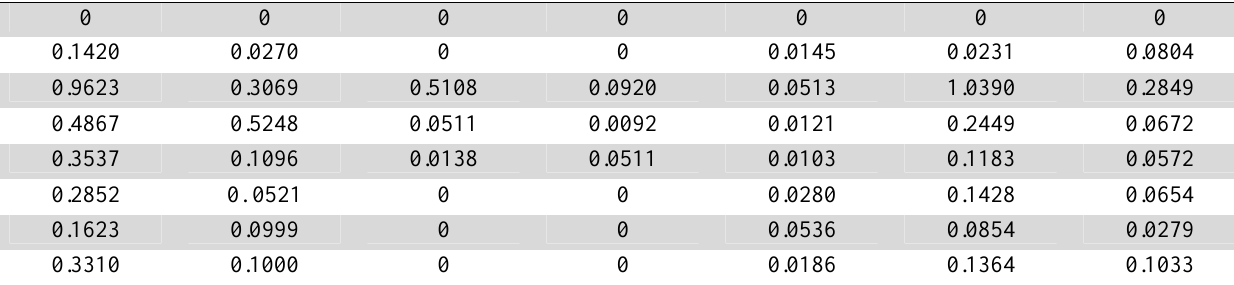
The summary of indirect